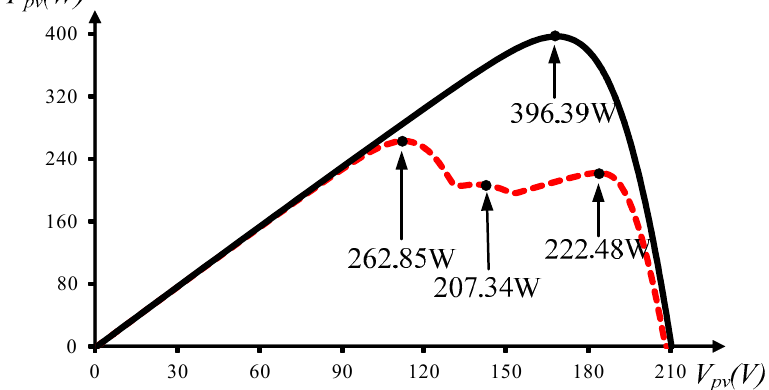
Figure 16. Output P–V curves of the photovoltaic module array being unshaded and shaded.